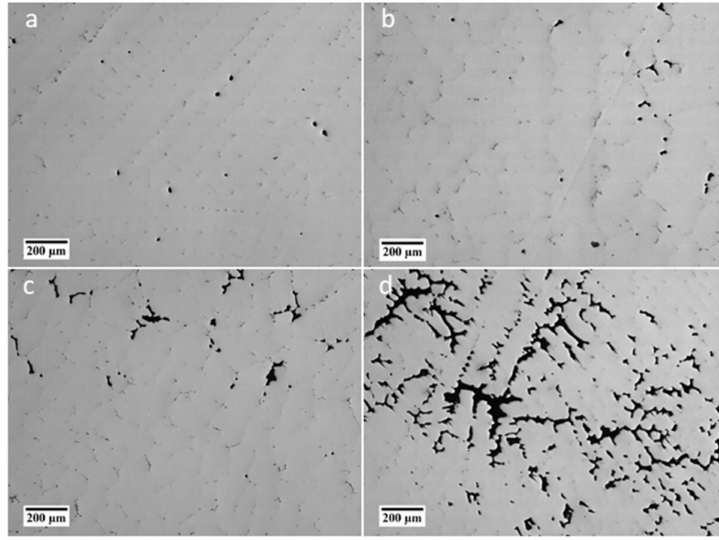
Figure 7. Porosity at distance: ( a ) 30 mm from surface, ( b ) 45 mm from surface, ( c ) 60 mm from surface, and ( d ) 70 mm from